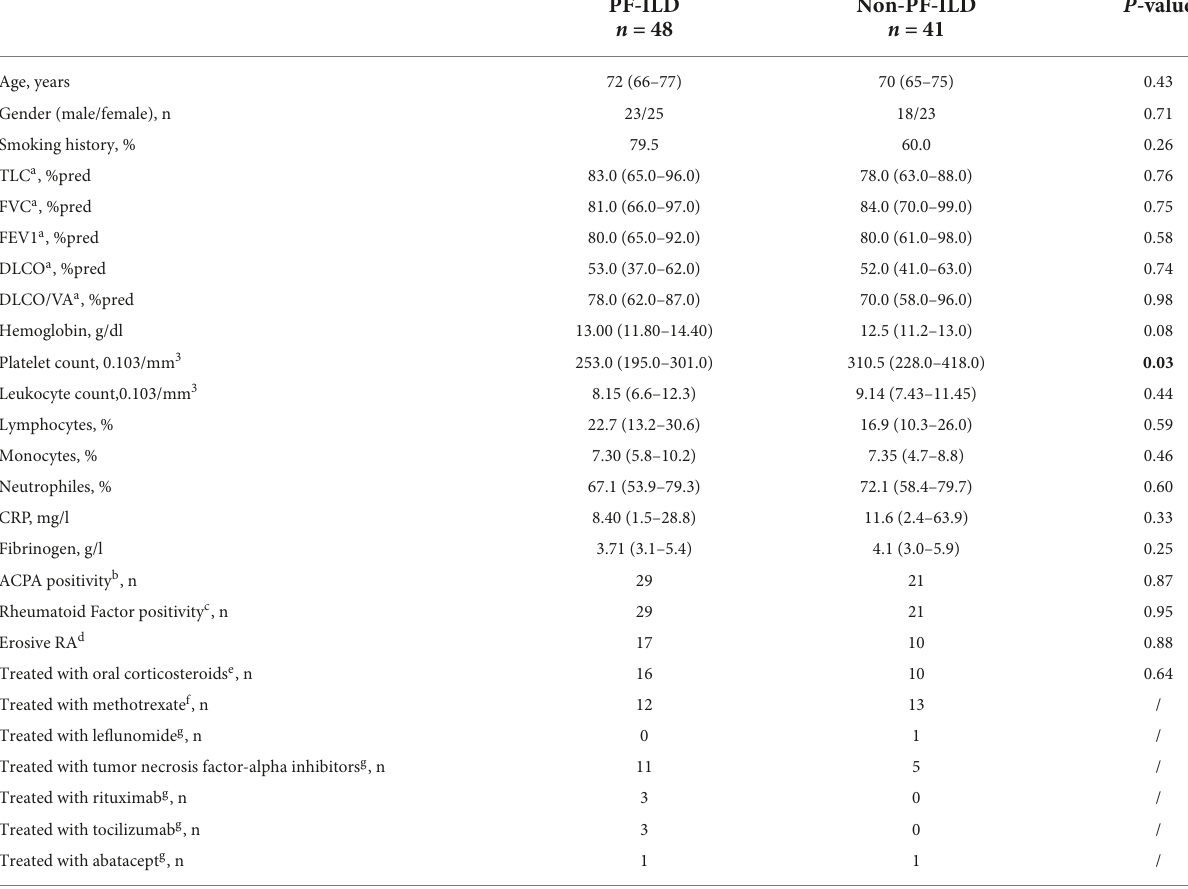
TABLE 2 Comparison of patients’ characteristics between PF-ILD ( n = 48) and non-PF-ILD patients ( n = 41) among RA-ILD ( n = 89).